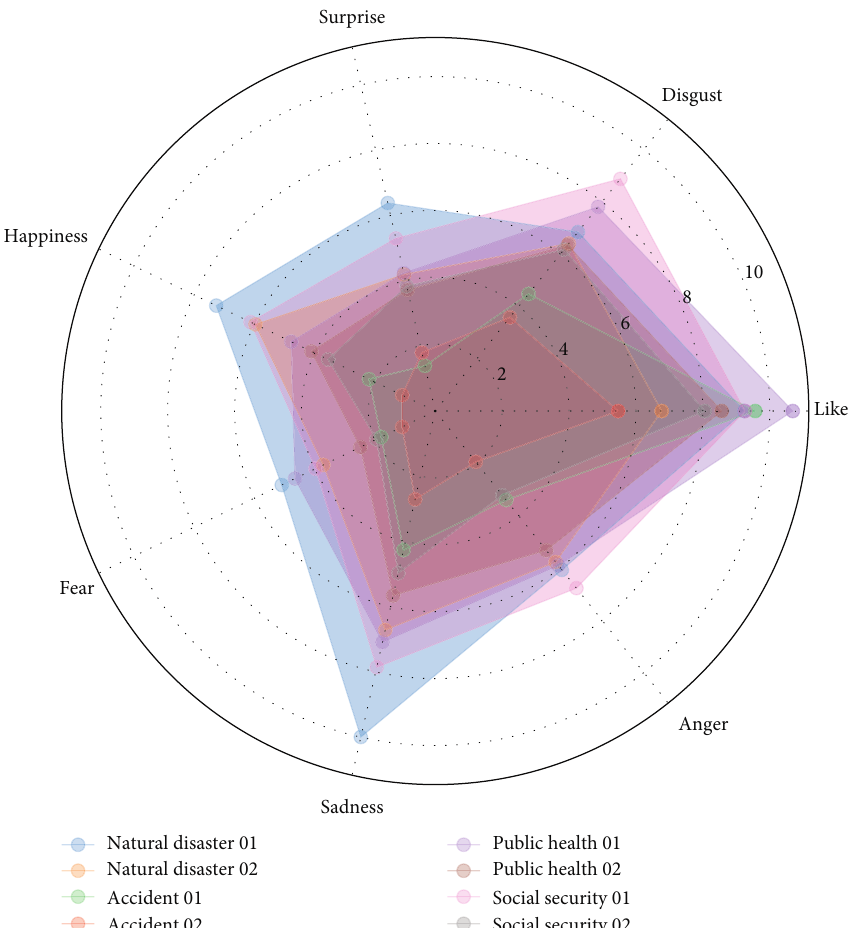
Figure 7: Multidimensional emotion radar diagram of public opinion derived from